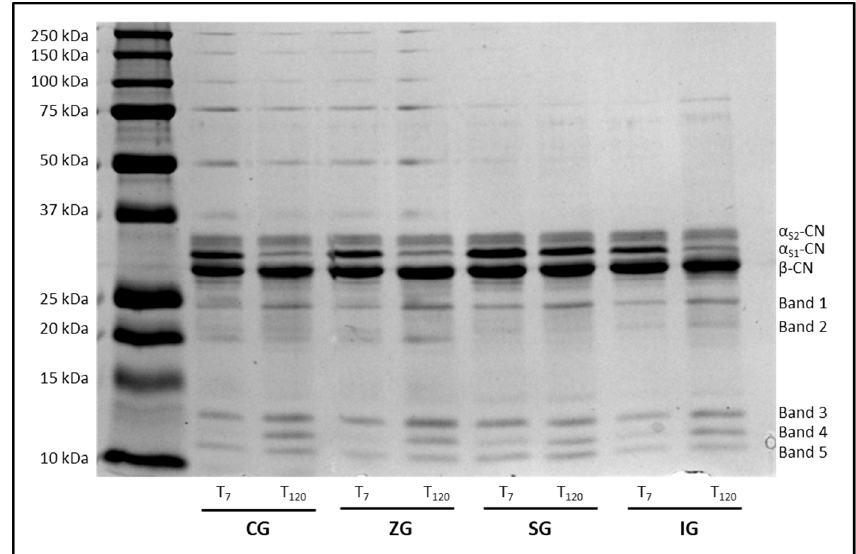
Figure 3. Sodium dodecyl sulfate polyacrylamide gel electrophoresis (SDS-PAGE) pattern of caseins and peptides resulting from protein degradation in fresh (T 7 ) and 120-days ripened (T 120 ) cheese samples obtained from lactating dairy cows fed control diet (CG) and control diet supplemented with zinc (ZG), selenium (SG), and iodine (IG).